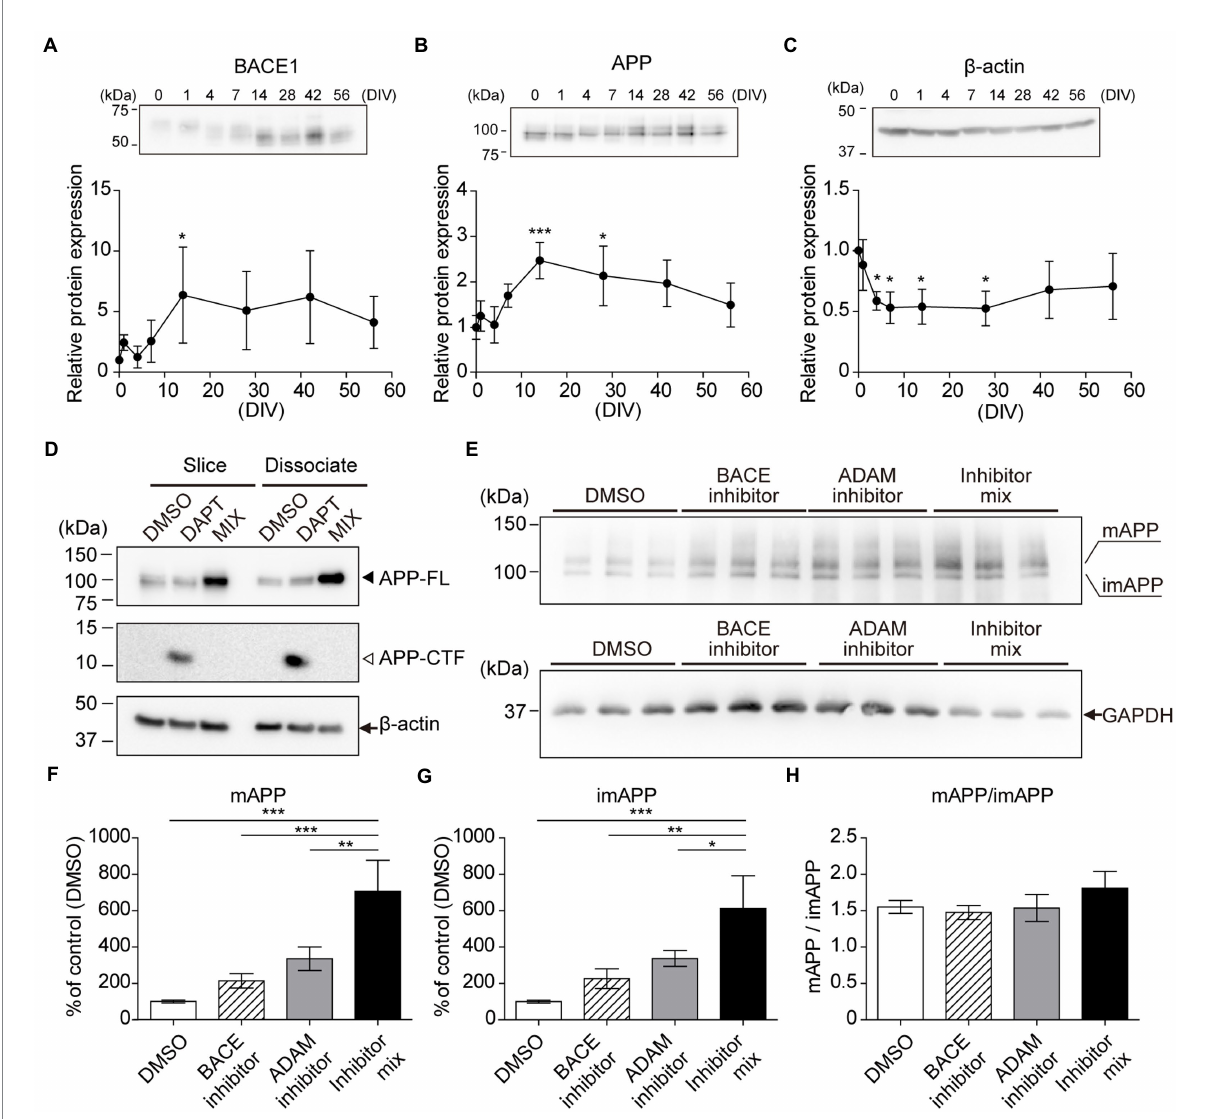
FIGURE 3 Chronological analysis of APP and BACE1 by immunoblotting. Immunoblotting analysis of hippocampal slices (0–56 days in vitro , DIV) using antibodies against BACE1 (A) , APP (B) , and GAPDH (C) . Each point (filled circle) denotes relative protein expression which was normalized to GAPDH and relative to a 0 DIV (acute slice) sample. Data were analyzed using one- way ANOVA, and pairwise comparison was performed according to Tukey–Kramer multiple comparison test. NS; p > 0.05, *; p < 0.05, **; p < 0.01, ***; p < 0.001 (vs. 0 DIV). Data are presented as mean ± SD, based on four independent experiments ( n = 4). Full-length blots are shown in Supplementary Figure S5. (D–H) Immunoblotting analysis of APP cleavage. (D) Cultured hippocampal slices (slice, 14DIV) or dissociated hippocampal cells (dissociated, 14DIV) treated with γ -secretase inhibitor (DAPT, 10 μ M) or secretase inhibitor mix (MIX; 10 μ M DAPT, 50 μ M ADAM inhibitor (GI254023X), and 2 μ M BACE inhibitor (BACE inhibitor IV) for 24 h. β -actin served as a loading control. APP-FL: full-length APP. APP-CTF: APP C-terminal fragment. (E–H) Cultured hippocampal slices (14DIV, n = 3) treated with an ADAM inhibitor (GI254023X, 50 μ M) and/or BACE1 inhibitor (BACE inhibitor IV, 2 μ M) for 24 h. Mature APP-FL (mAPP) and immature APP-FL (imAPP) levels were evaluated quantitatively. Open bar, DMSO; stripe bar, BACE inhibitor; gray bar, ADAM inhibitor; black bar, BACE inhibitor and ADAM inhibitor mix. GAPDH served as a loading control. Full-length blots are shown in Supplementary Figure S6. Statistical significance was tested by one-way ANOVA, and pairwise comparison was performed according to Tukey–Kramer multiple comparison test. NS; p > 0.05; *; p < 0.05; **; p < 0.01; ***; p < 0.001. Data are presented as mean ± SD, based on three independent experiments ( n =